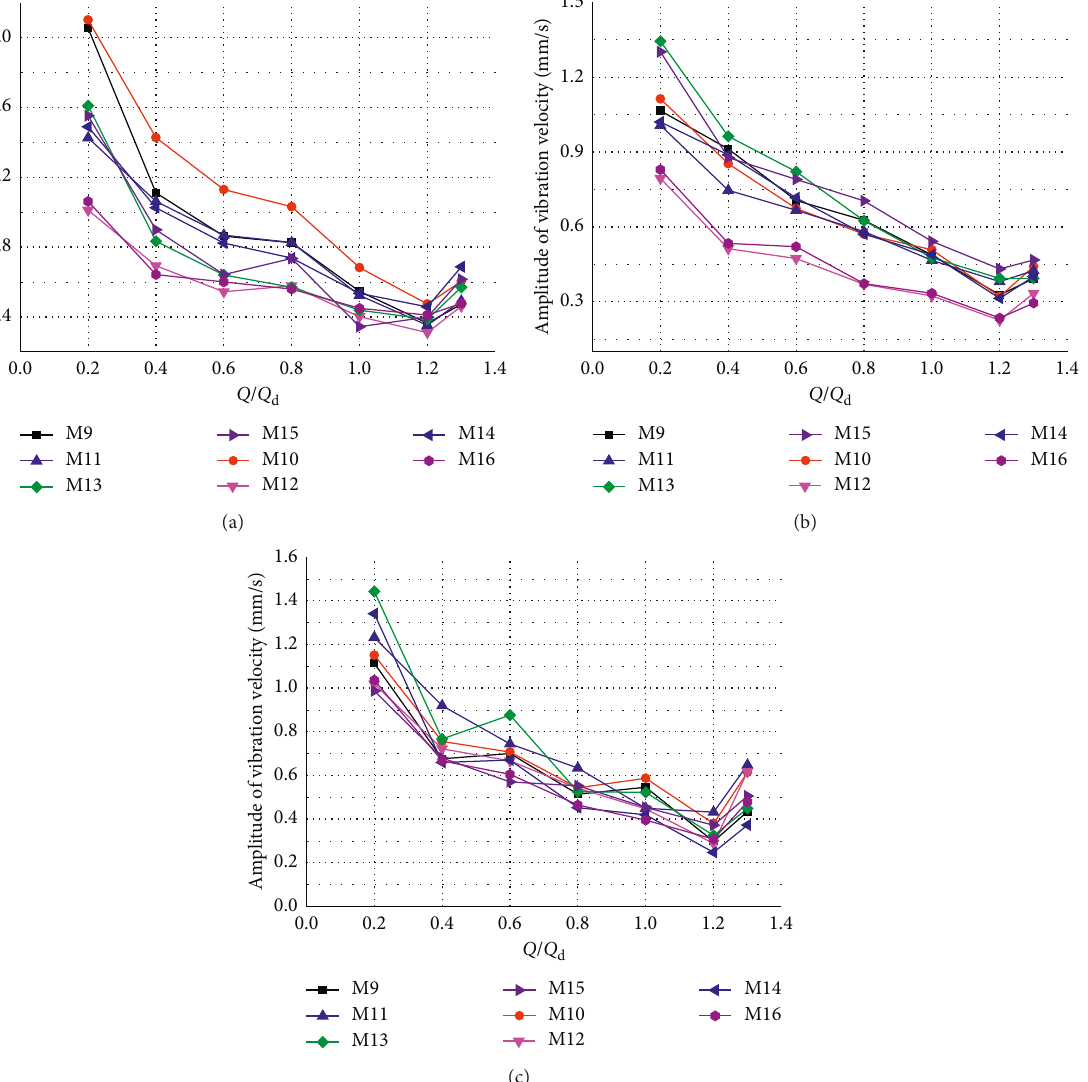
Figure 7: Amplitudes of vibration velocity at M9 ∼ M16 in the (a) X direction, (b) Y direction, and (c) Z